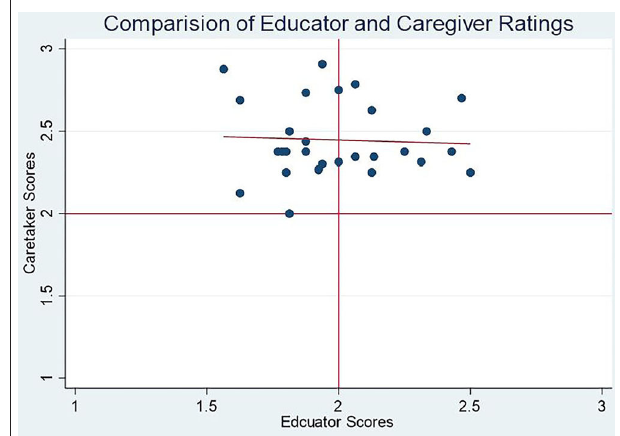
FIGURE 5 | Comparison of caregiver and teacher scores for individual